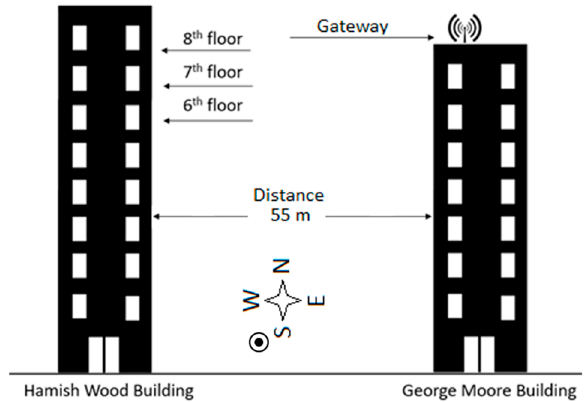
Figure 1. Studied environment at Glasgow Caledonian University (GCU).